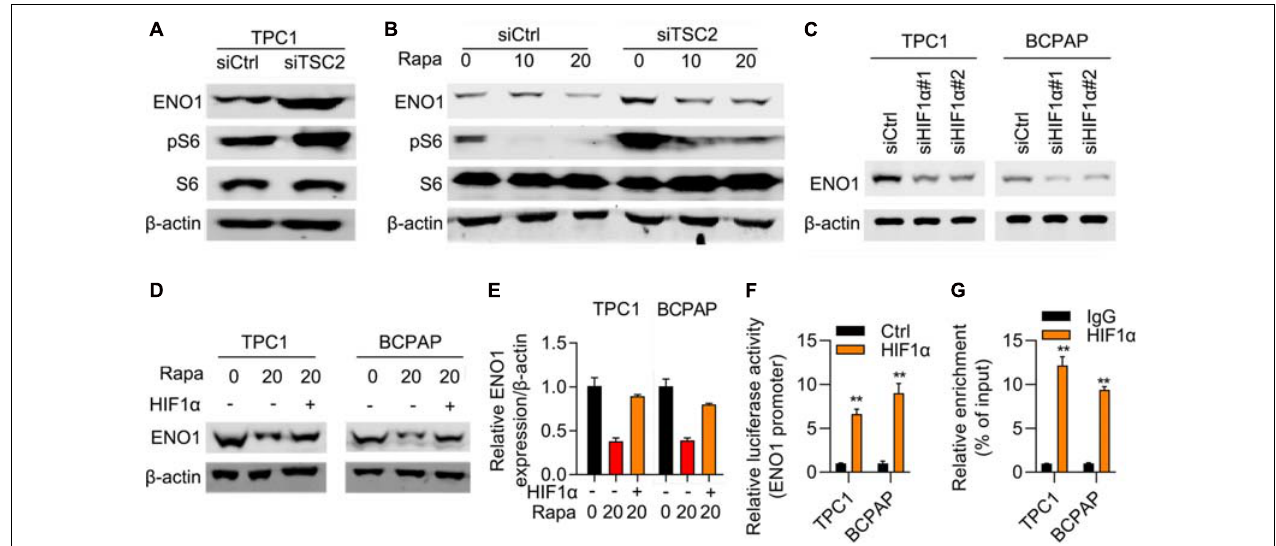
FIGURE 5 | mTOR/HIF1 α regulates expression of ENO1. (A) ENO1 and phosphorylated S6 was upregulated in TSC1 knockout TPC1 cells. β -actin was used as a loading control. (B) ENO1 was downregulated with rapamycin treatment. β -actin was used as a loading control. (C) Depletion of HIF1 α downregulated expression of ENO1. β -actin was used as a loading control. (D–E) HIF1 α rescued downregulation of ENO1 with rapamycin treatment. Western blotting (D) and qRT-PCR (E) were shown. ** P < 0.01. (F) ENO1 luciferase assay in control and HIF1 α transfected cells. ** P < 0.01. (G) HIF1 α targeted the promoter region of ENO1. ChIP-qPCR results are shown. ** P <